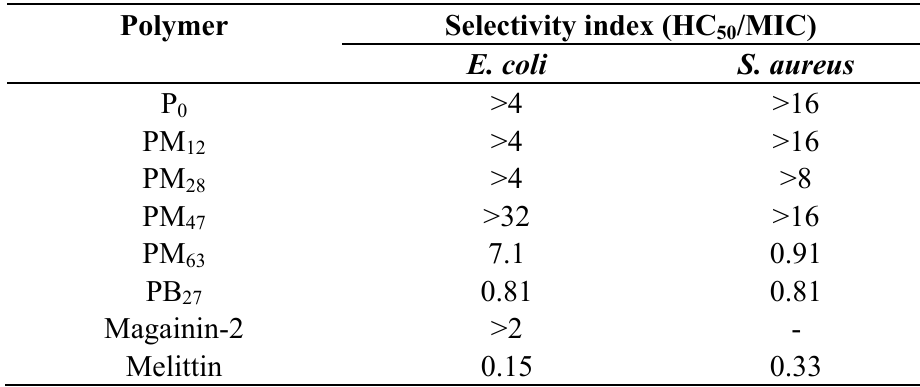
Table 3. Selectivity of PMAs and control